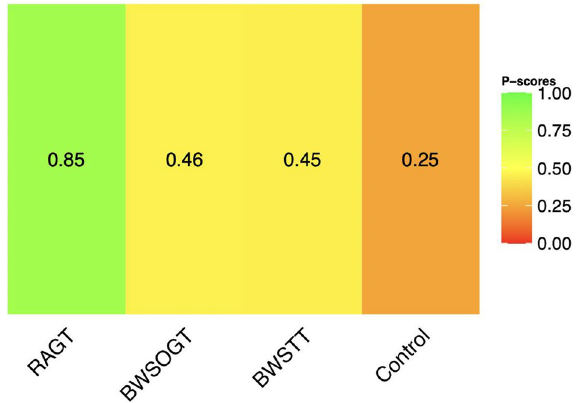
Figure 5. Distribution of probabilities in the ranking of each body weight–supported gait training strategy. The ranking probabilities indicated that RAGT was the most effective, followed by BWSOGT, BWSTT, and the